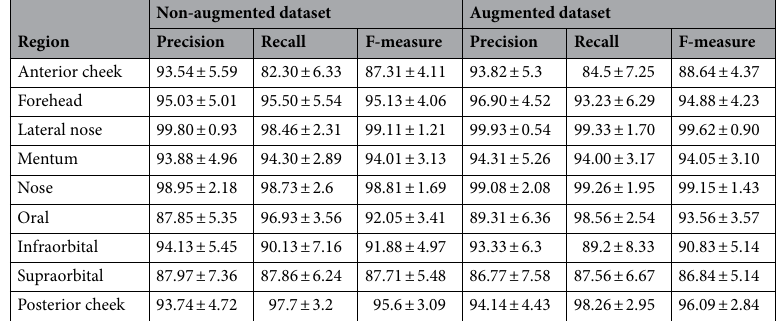
Table 4. Performance on the test set of the model with the non-augmented dataset and the models with the augmented dataset (region) (mean ± standard deviation %).